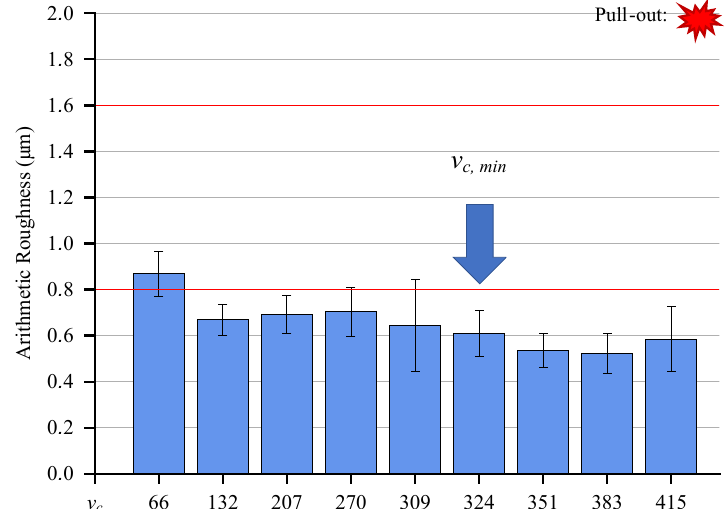
Figure 16. Determination of the minimal cutting speed of the thermoplastic tool, evolution of the arithmetic roughness (µm) for different v c (m/min) with f z = 0.030 mm/tooth, a p = 3 mm, and a e = 0.5 mm. No material pull-out was observed.